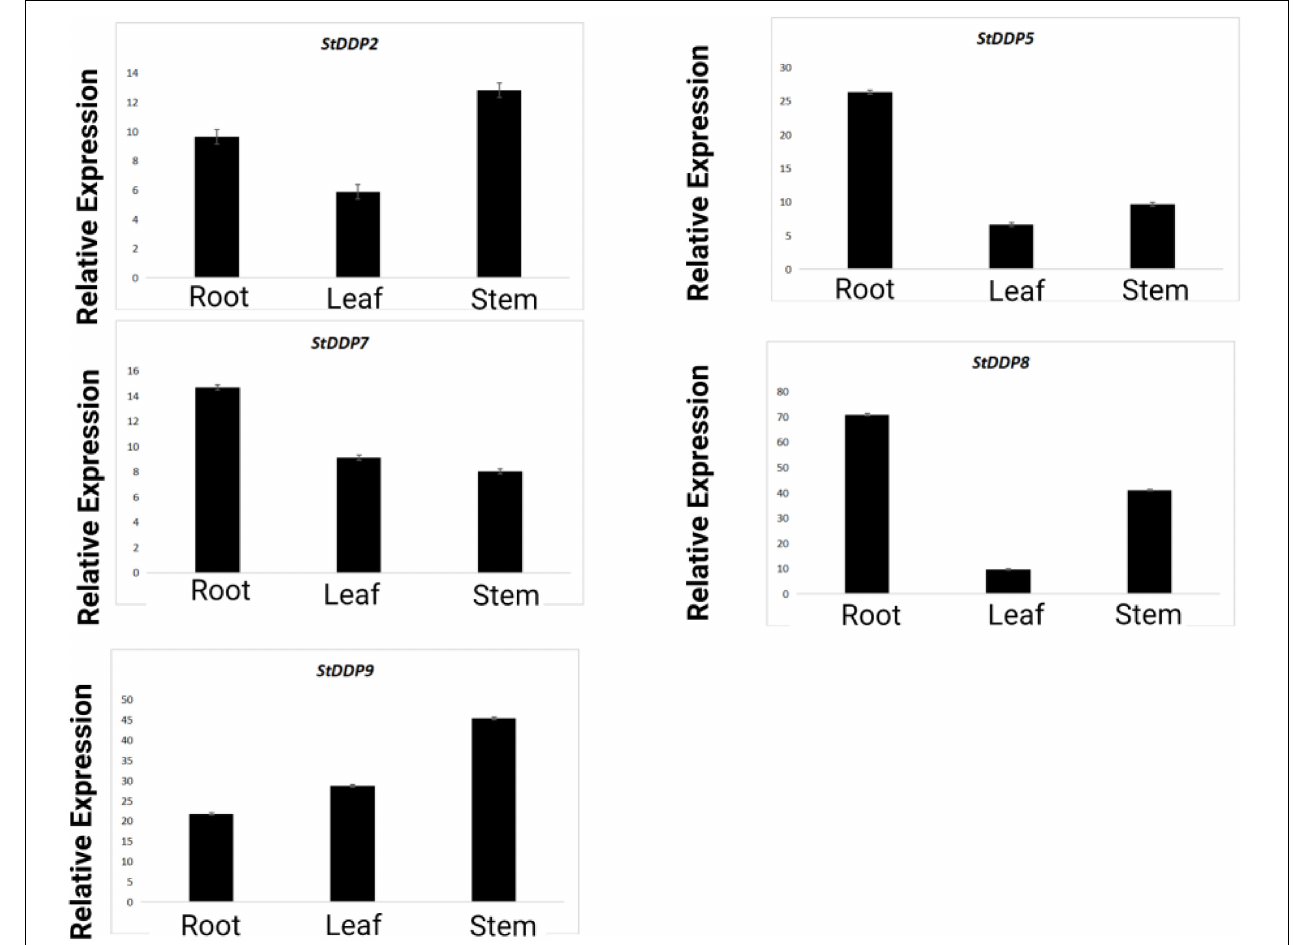
FIGURE 10 | Real-time relative expressions of StDDPs in leaves, roots, and